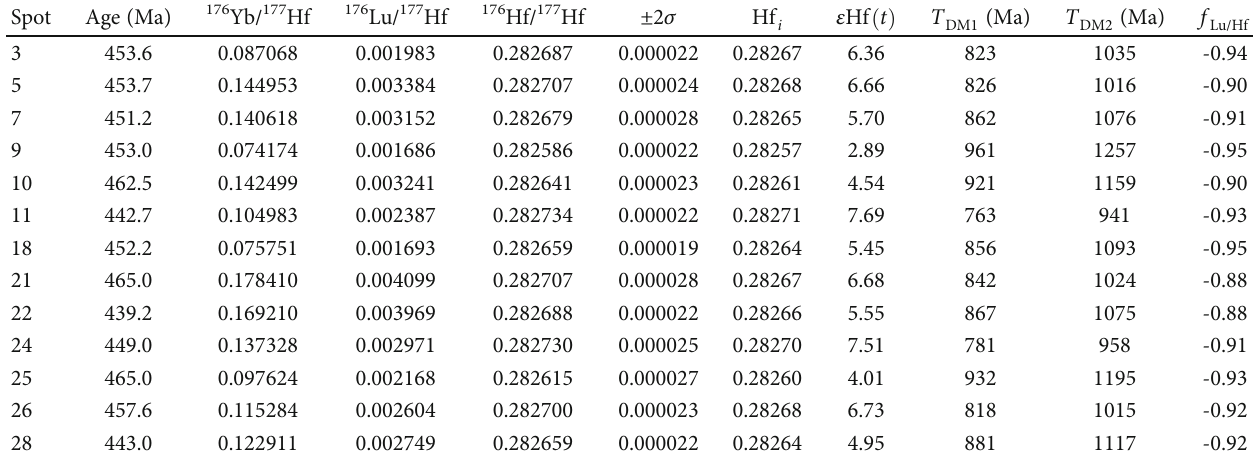
Table 2: Lu-Hf isotopic analyses for zircons from the Bieyesamas